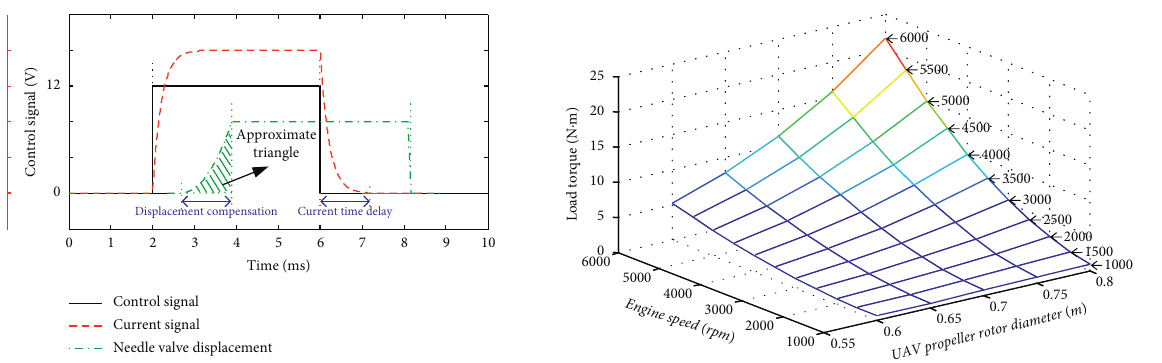
Figure 8: Horizontal torque of the propeller under different working